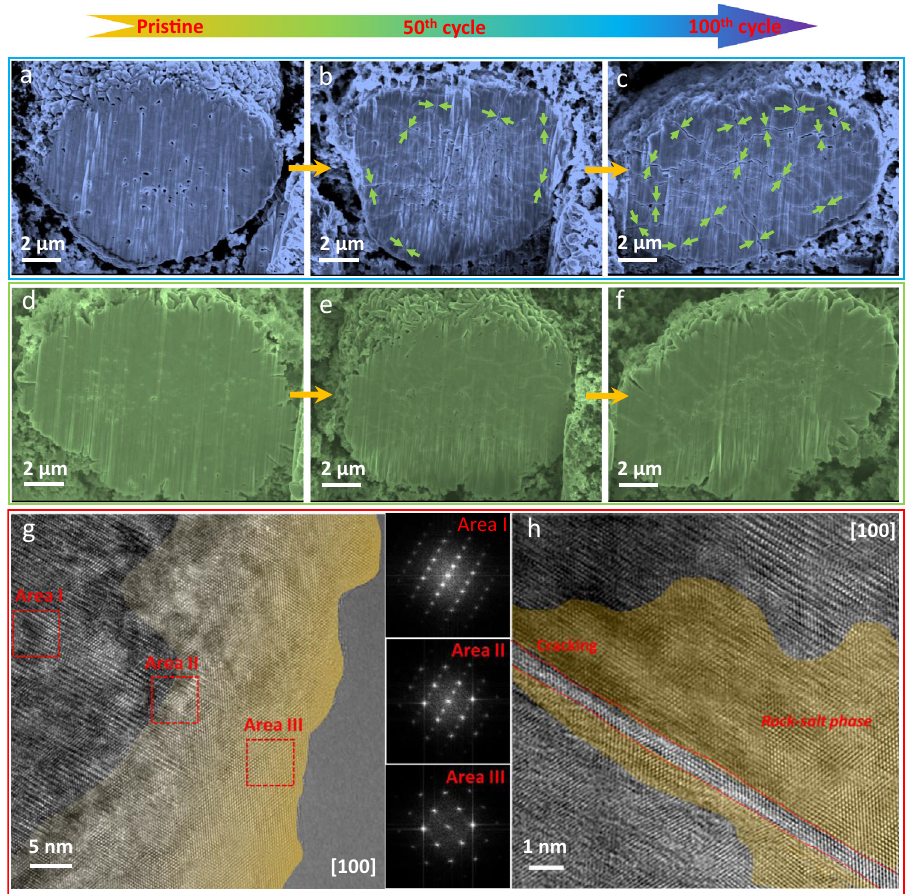
Fig. 6 Ex situ postmortem FIB-SEM and TEM electrode characterizations of two gradient cathodes. a – c Cross-sectional images of pristine NC-NM82 particle, NC-NM82 after 50 cycles, and NC-NM82 after 100 cycles, respectively. The scale bar is 2 µ m. d – f Cross-sectional images of pristine NM-NC82 particle, NM-NC82 after 50 cycles, and NM-NC82 after 100 cycles, respectively. The scale bar is 2 µ m. g , h High-resolution TEM images of the cycled NC- NM82 surface area and the NC-NM82 cracking area. The scale bars are 5 and 1 nm,